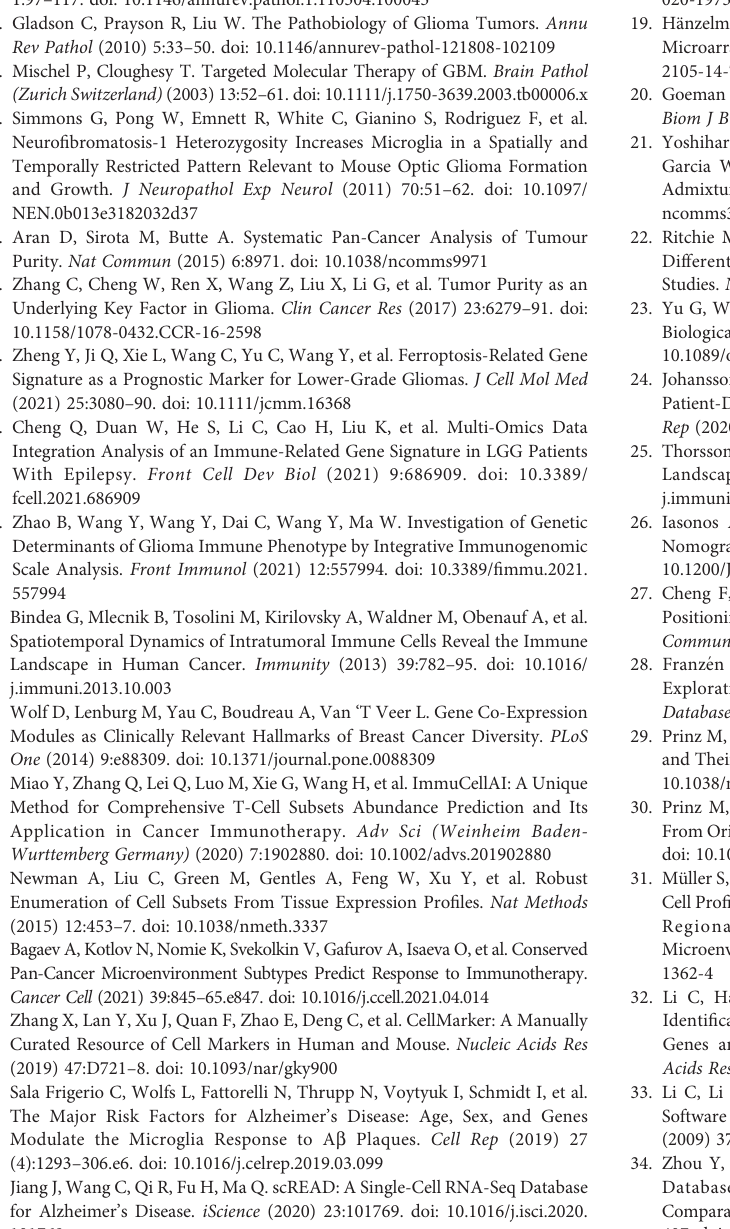
Supplementary Figure 1 | Kaplan-Meier estimate of the overall survival of the TCGA-GBM (PFS)(A), TCGA-LGG (PFS) (B) , TCGA-GBM&LGG (OS) (C) and TCGA-GBM&LGG (PFS) (D) divided by two GMEFS model. Supplementary Figure 2 | TCGA GBM patients were classi fi ed into high and low GMEFSgroups.Visualizationofthetop10enrichedbiologicalprocesses (A) andthetop 10 enriched KEGG pathways (B) by the DEGs in the high versus low GMEFS groups. Supplementary Figure 3 | (A) the venn plot between DEGs from TCGA LGG high GMEFS and low GMEFS groups, and glioma related gene set.